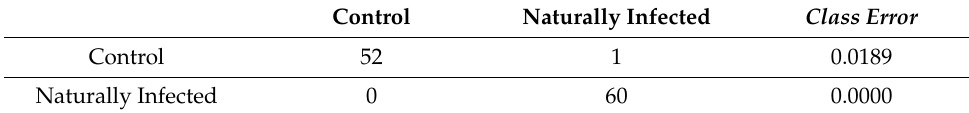
Table 1. Cross validation results of the random forest assessments for leukotriene B4, bicyclo-PGE2,